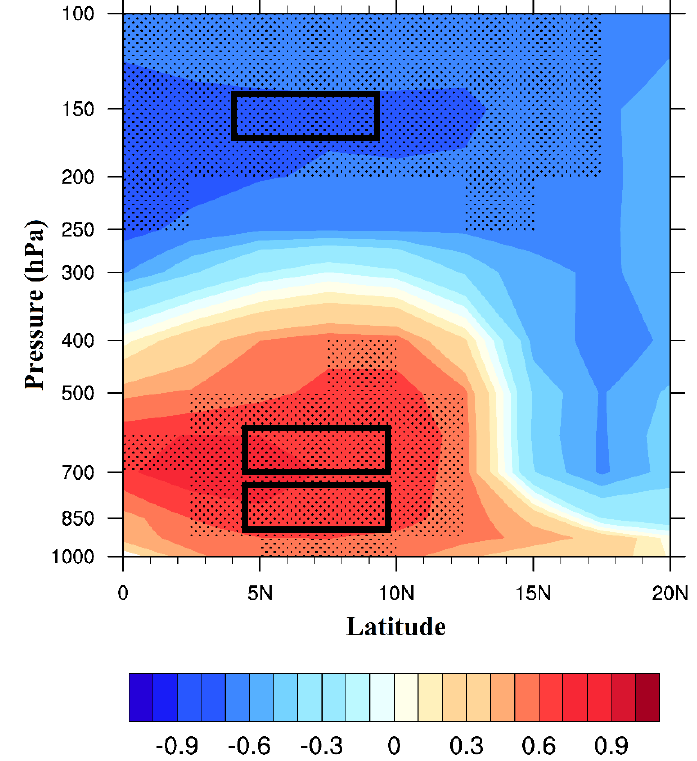
Figure 7. Correlation between JJAS zonal wind and area-averaged summer monsoon rainfall over West Africa (4°–16° N, 20° W–20° E). Stippling indicates regions where changes are significant at the 95% level.